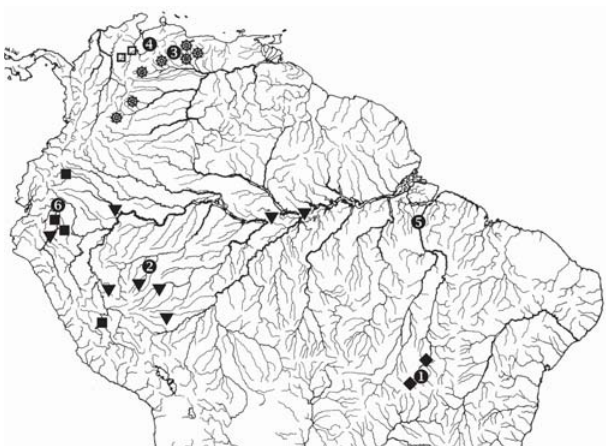
Fig. 2. Map of central and northern portions of South America showing geographic distribution of the species of Lamontichthys (numbers indicate type localities): 1. L . avacanoeiro (lozenge), 2. L . filamentosus (triangle), 3. L . llanero (rudder), 4. L . maracaibero (open squares), 5. L . parakana (number 5), and 6. L . stibaros (solid squares). Some symbols represent more than one locality or lot of specimens.